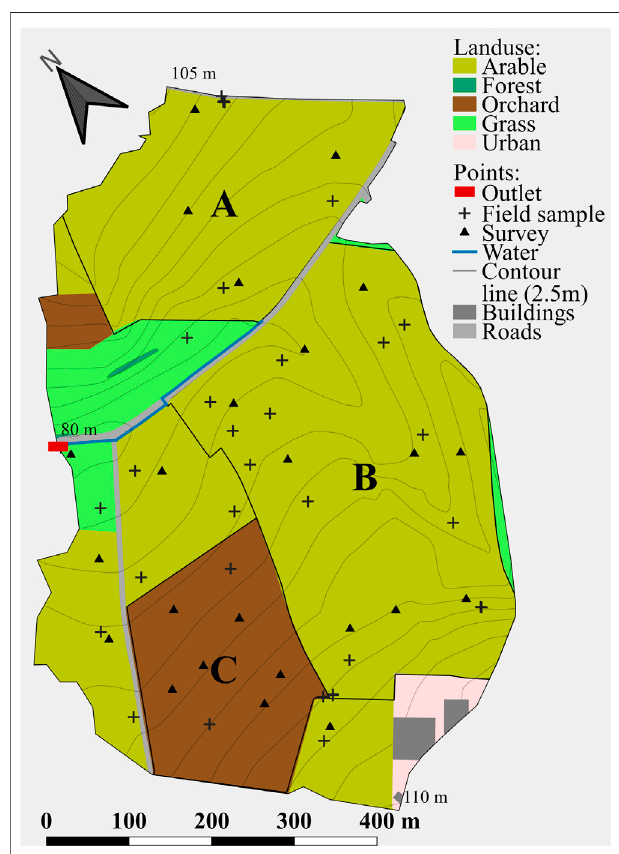
FIGURE 1 | Map of the study area in South-Limburg, the Netherlands indicating sampling points. The letters (A,B and C) indicate the three fi elds of main interest in this